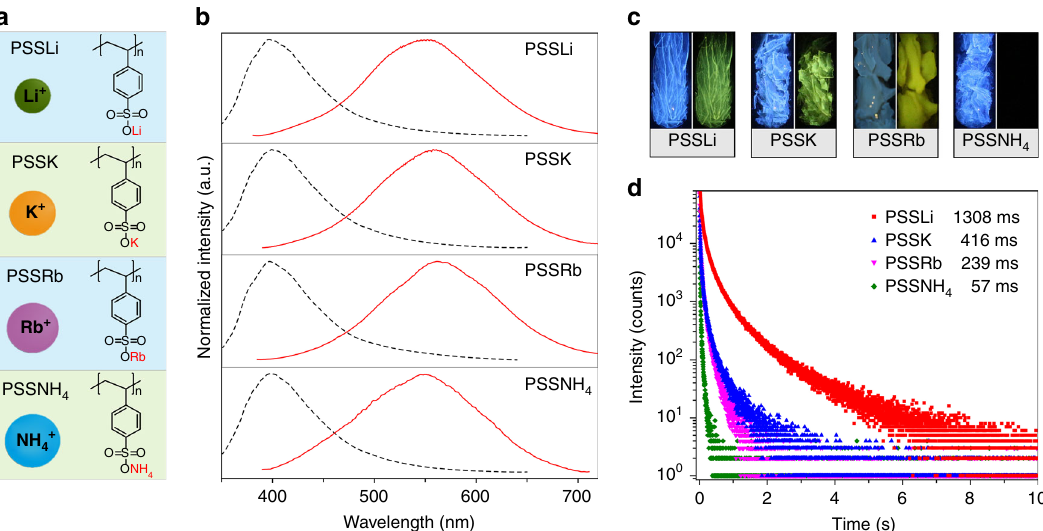
Fig. 3 Photoluminescence investigation of polymers with different ion linkers in solid state under ambient conditions. a Chemical structures of PSSLi, PSSK, PSSRb, and PSSNH 4 polymers. b Steady-state photoluminescence (dash lines) and phosphorescence (solid lines) spectra of PSSLi, PSSK, PSSRb, and PSSNH 4 polymers, respectively. c Photographs of PSSLi, PSSK, PSSRb, and PSSNH 4 polymers taken before (left) and after (right) turn-off of a 365 nm UV lamp. d Lifetime pro fi les of the phosphorescence emission bands at 550 nm for PSSLi, PSSK, PSSRb, and PSSNH 4 polymers excited by 365